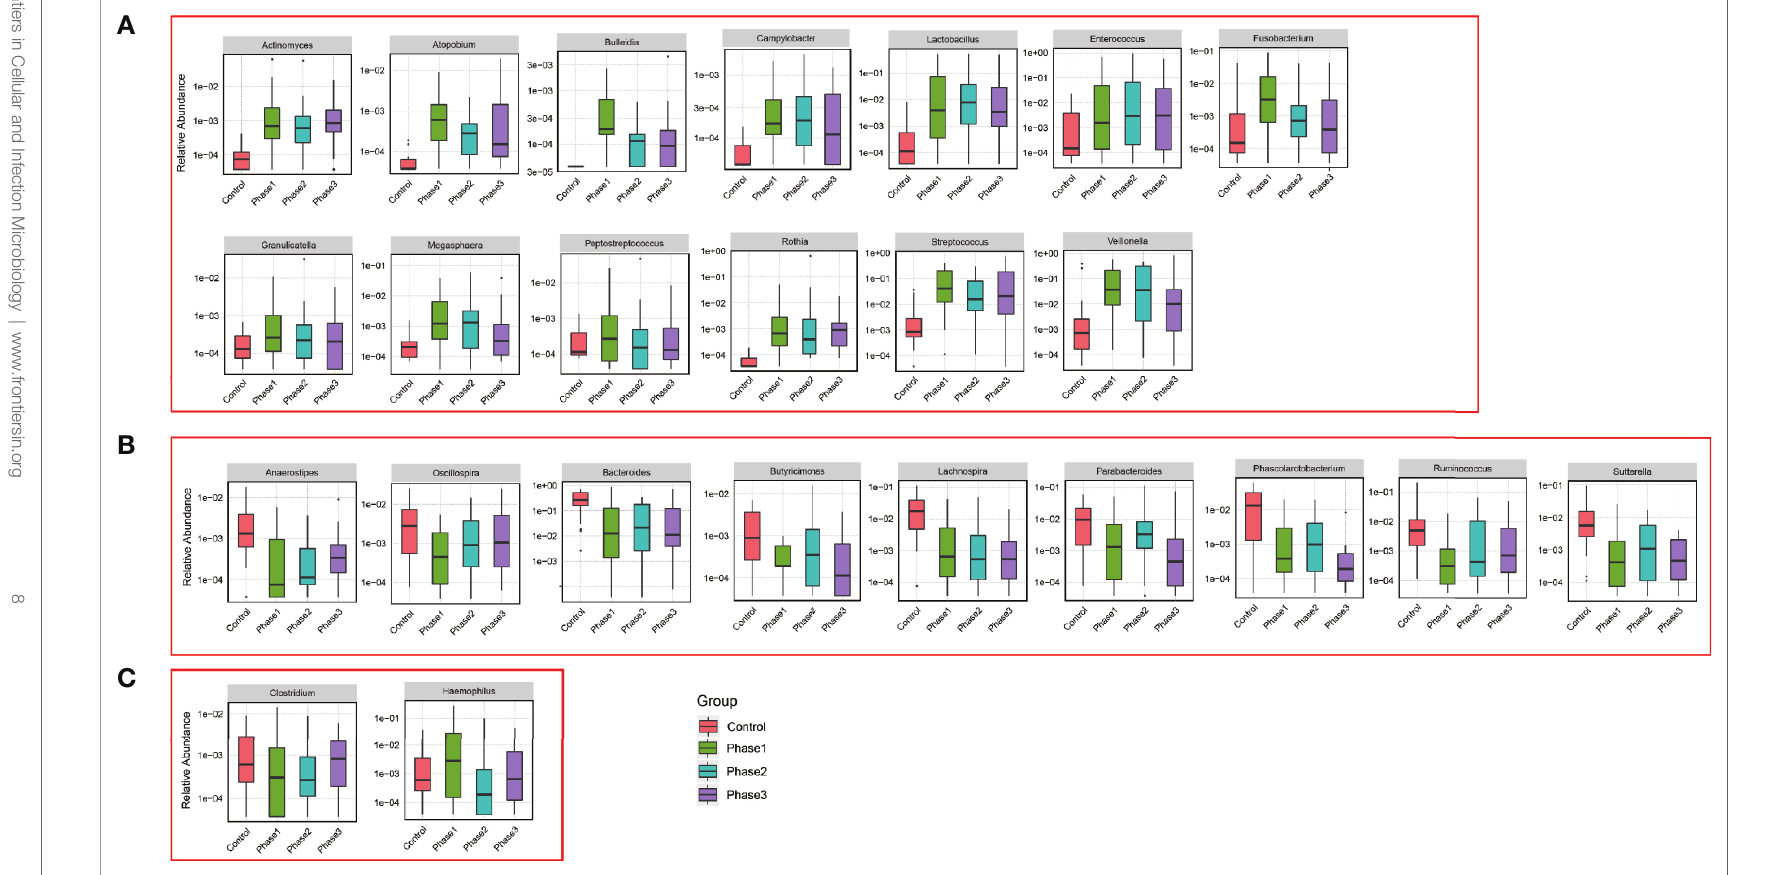
FIGURE 4 | Relative abundance of genus that was statistically signi fi cant correlated with HBV-ACLF. Phase 1 (green boxplot), phase 2 (blue boxplot), phase 3 (purple boxplot), and control (red boxplot). (A) Relative abundance was signi fi cantly increased. (B) Relative abundance was signi fi cantly reduced. (C)